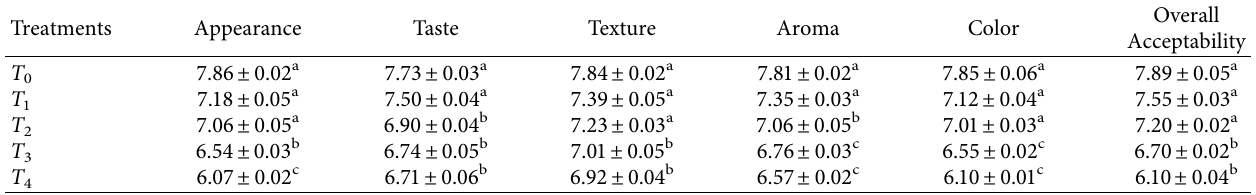
Table 8: Sensory attributes of moringa leaf powder (MLP)-supplemented whole wheat four leavened bread.